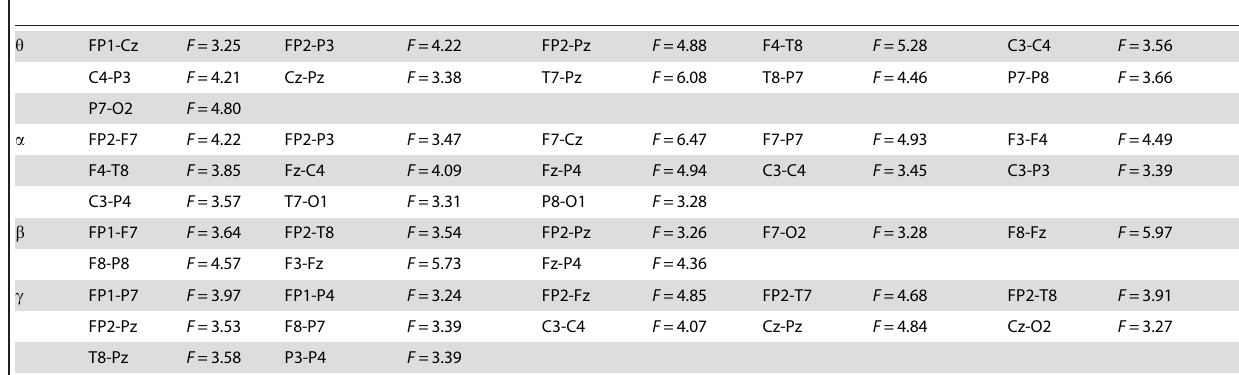
Table 3. Significant Results of F-test and Tukey Test of Phase Synchronization Index (p ,